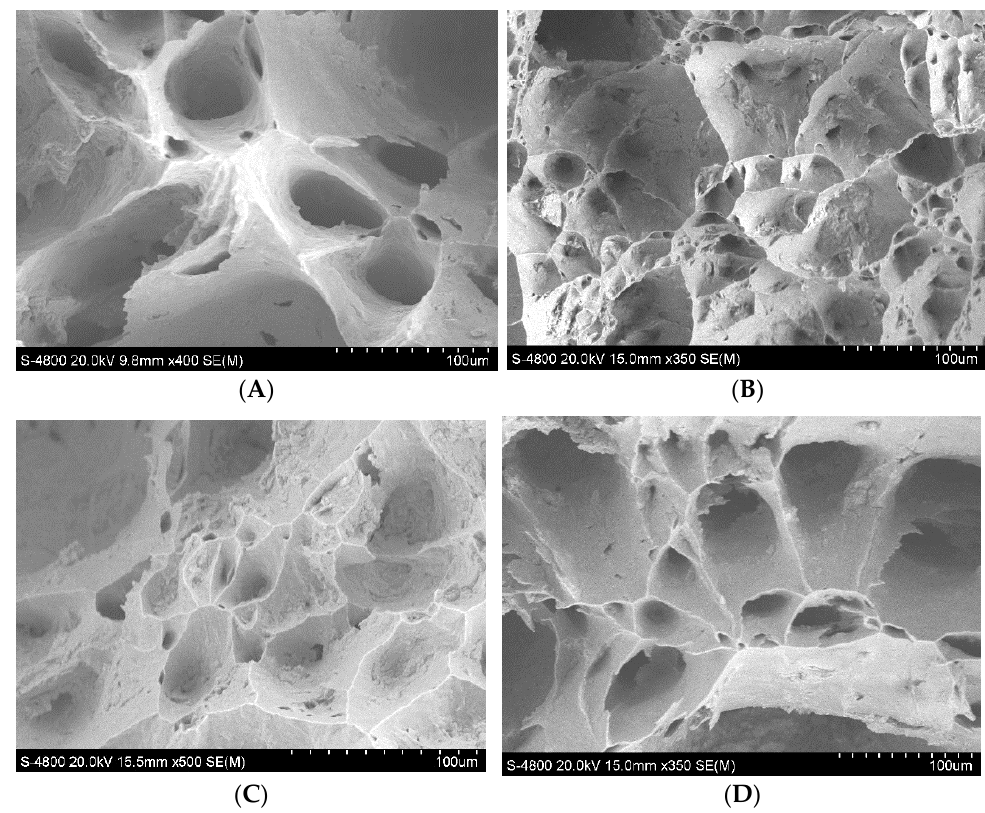
Figure 9. Electron microscopy images of the morphology of the fracture surface of the tensile speci-mens of the samples ( A – D ) at 850 °C.